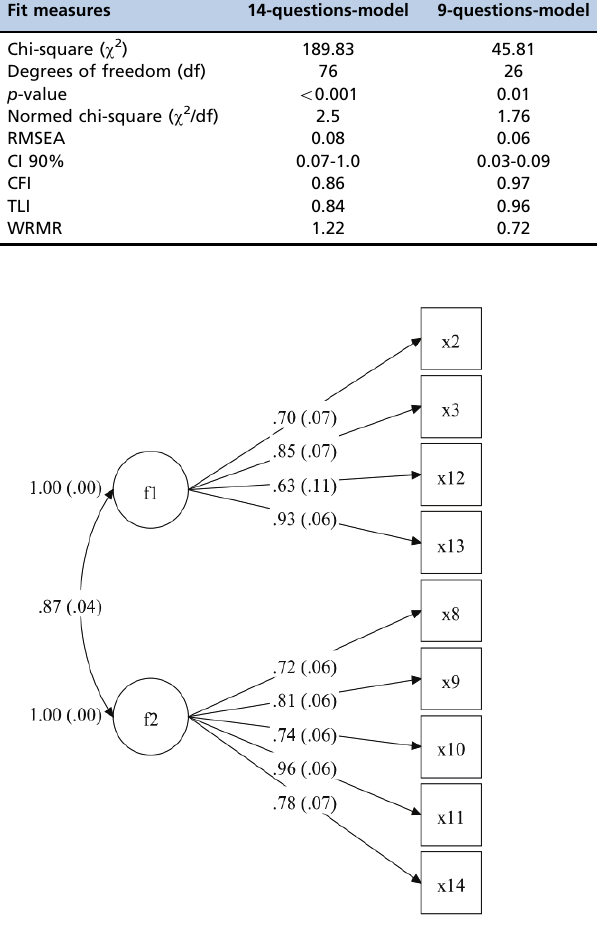
Figure 2 - The second-order model of measurement of the constructs according to CFA. The fit model was adjusted with 9 observable variables: x2: Multiple swallows; x3: Swallowing with effort; x8: Throat clearing; x9: Wet voice; x10: Choking; x11: Recurrent pneumonia; x12: Weight lost; x13: Painful swallowing; and x14: Fatigability. These variables are confirmed into two factors (latent variables): f1: non-efficiency swallowing; f2: unsafe swallowing. Correlation between factors f1 and f2 was classified as strong ( F =0.87; SE=0.04).